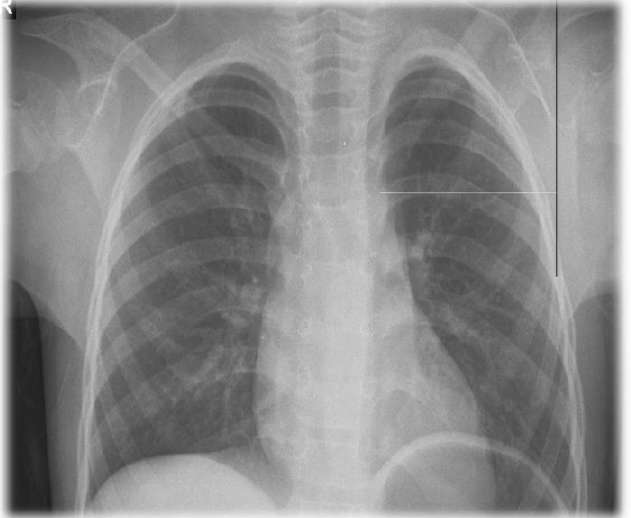
Figure 5. Chest X-ray findings of the patient. The angle of the clavicles with the sternum is wider than